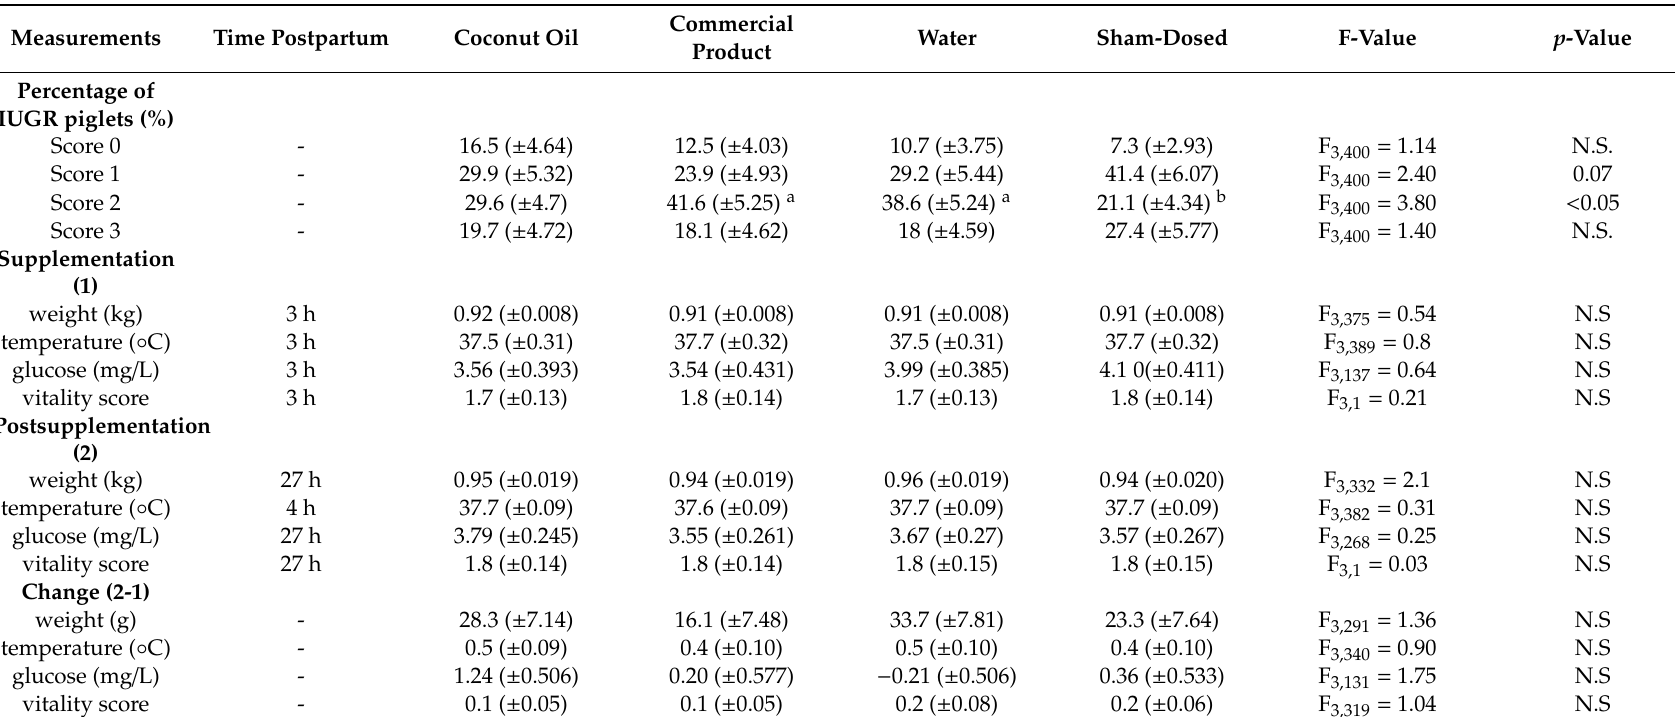
Table 3. Mean ( ± SE) values for the variables measured (intra-uterine growth retardation (IUGR) score, weight, rectal temperature, blood glucose content and vitality score (0–2)) at the time of supplementation (3 h postpartum) and 1 h (rectal temperature only) and 24 h postsupplementation. Piglets were either given a 2 mL